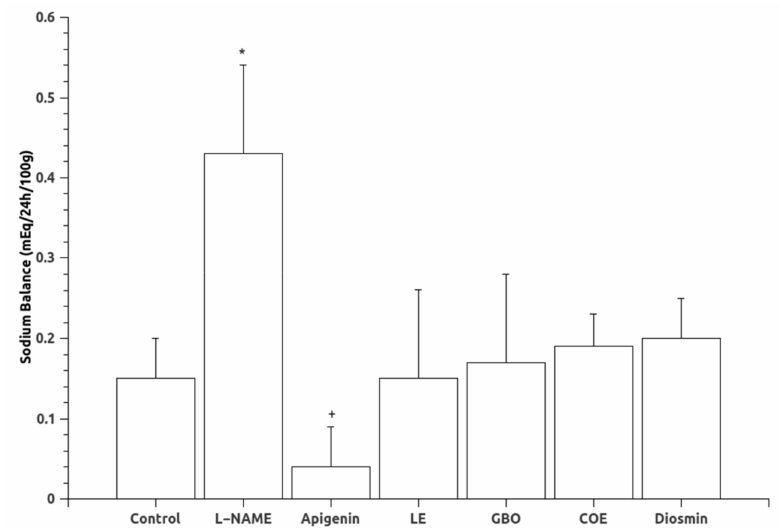
Figure 2. Sodium balance in the experimental groups. Abbreviations: L-NAME: ( N (G)-Nitro- L -arginine methyl ester), LE (Lemon extract), GBO (Grapefruit + bitter orange extract), COE (Cocoa extract). Data are mean ± S.E.M. * p < 0.05 vs. Control; + p < 0.05 vs.